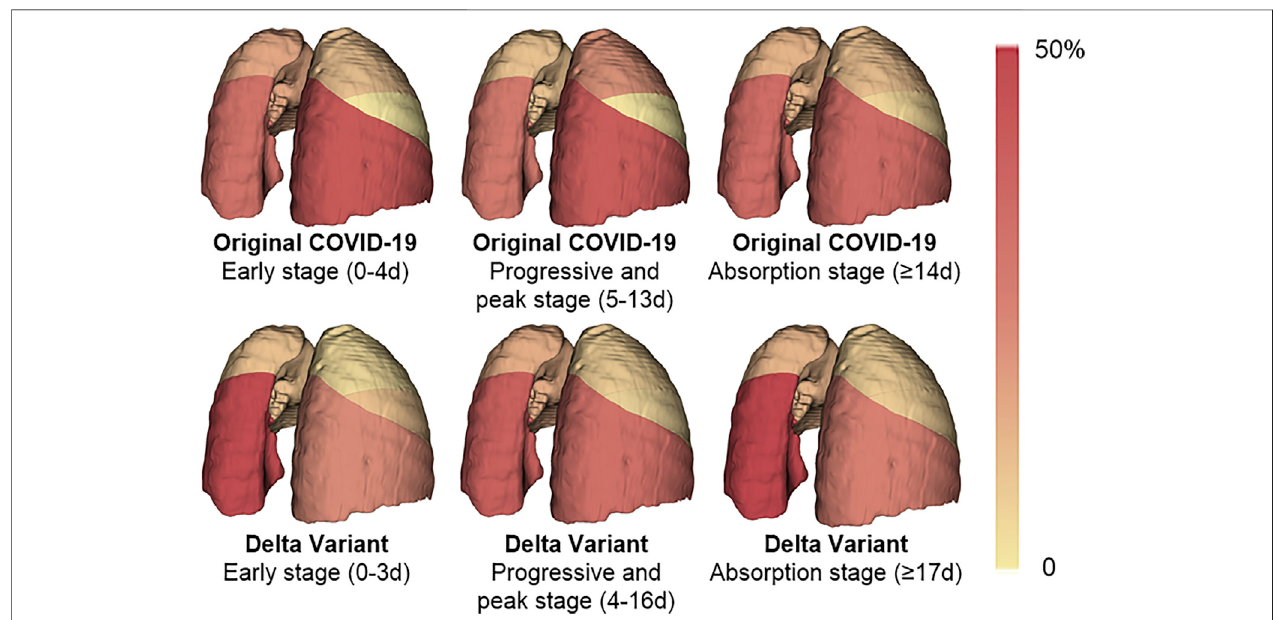
FIGURE 7 | A heat map of the distribution of pneumonia. The color of the lung lobe represents the percentage of infection in the lobe to infection in the whole lung. The percentage is taken from the average of patients. The deeper the color is, the larger the percentage is.